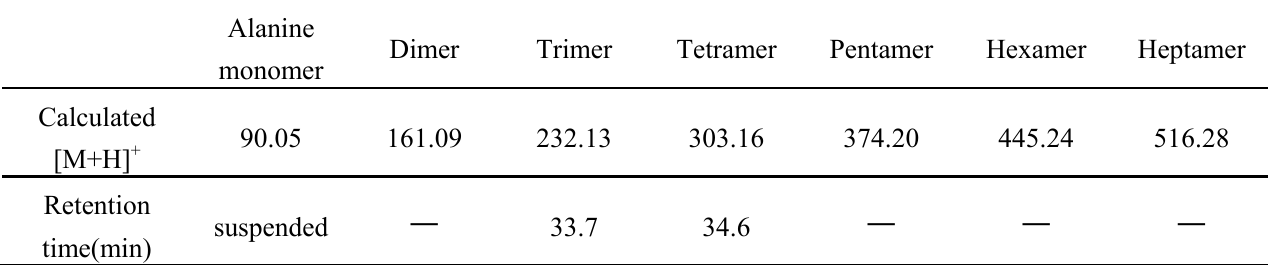
Table 2. Polymers obtained from pyruvic acid and hydroxylamine in supercritical conditions. Alanine